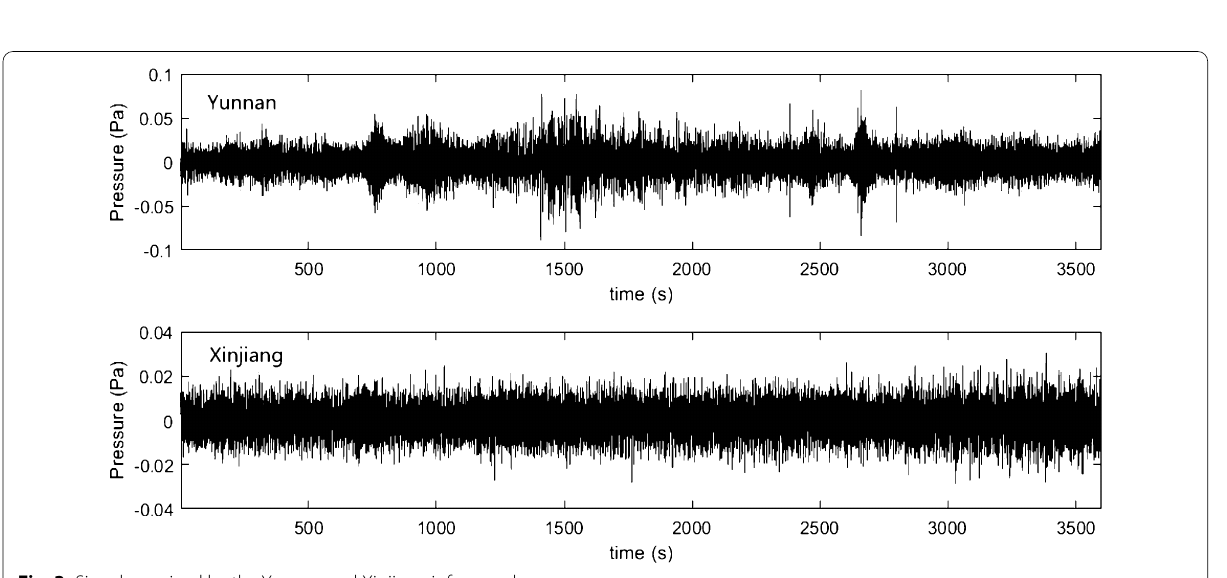
Fig. 3 Signals received by the Yunnan and Xinjiang infrasound